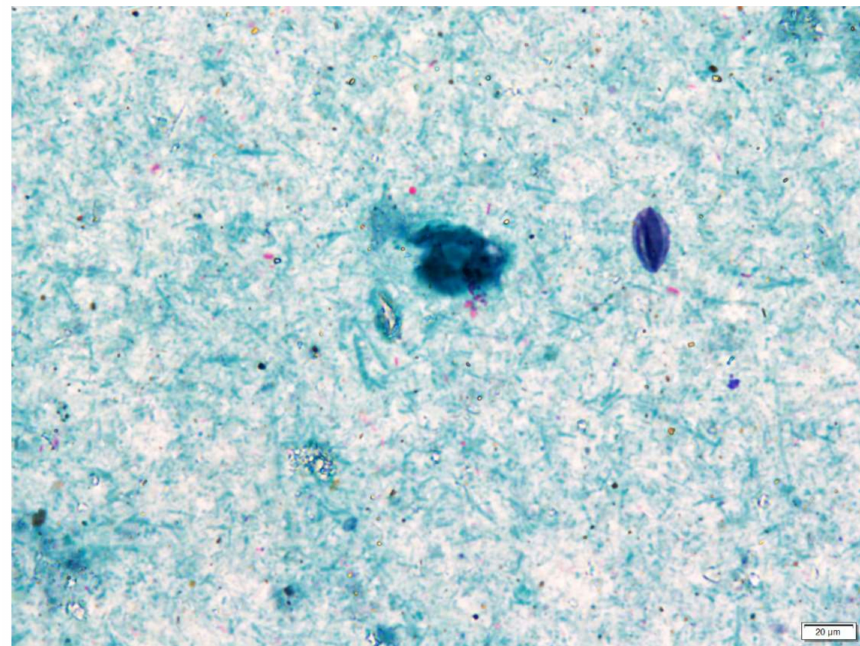
Figure 8. Direct microscopy after the Ziehl–Neelsen staining of the sediment sample (magnified 1000 times); the blue background is represented by a large amount of non-specific microflora present. Numerous acid-resistant, red-coloured polymorphic artefacts were visible, and there were only a few acid-fast bacteria (rod-shaped mycobacterial cells) in this microscopic field of view. This sample was culture-positive for M. avium ssp. hominissuis